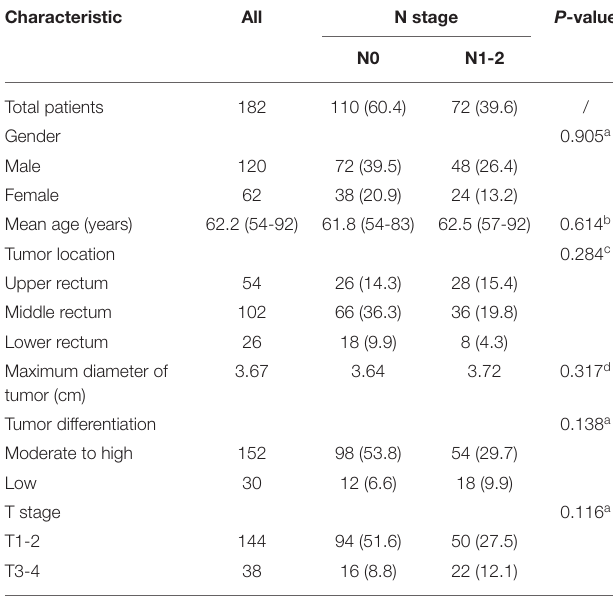
TABLE 2 | Clinical and pathological characteristics of